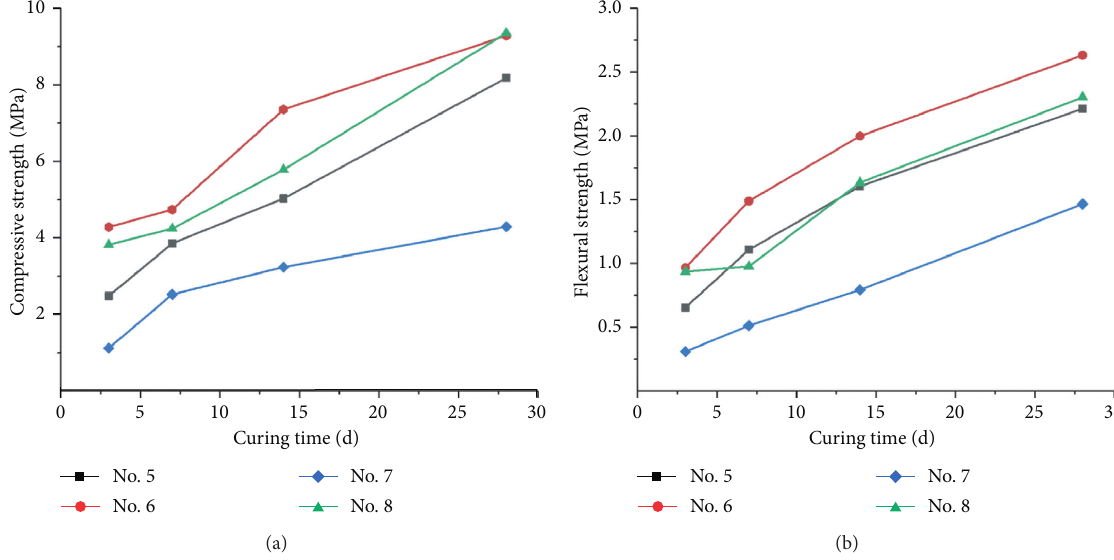
Figure 4: Mechanical properties of slurry with a water-solid ratio of 0.8:1 at different curing ages: (a) curve of unconfined compressive strength with time and (b) curve of flexural strength with